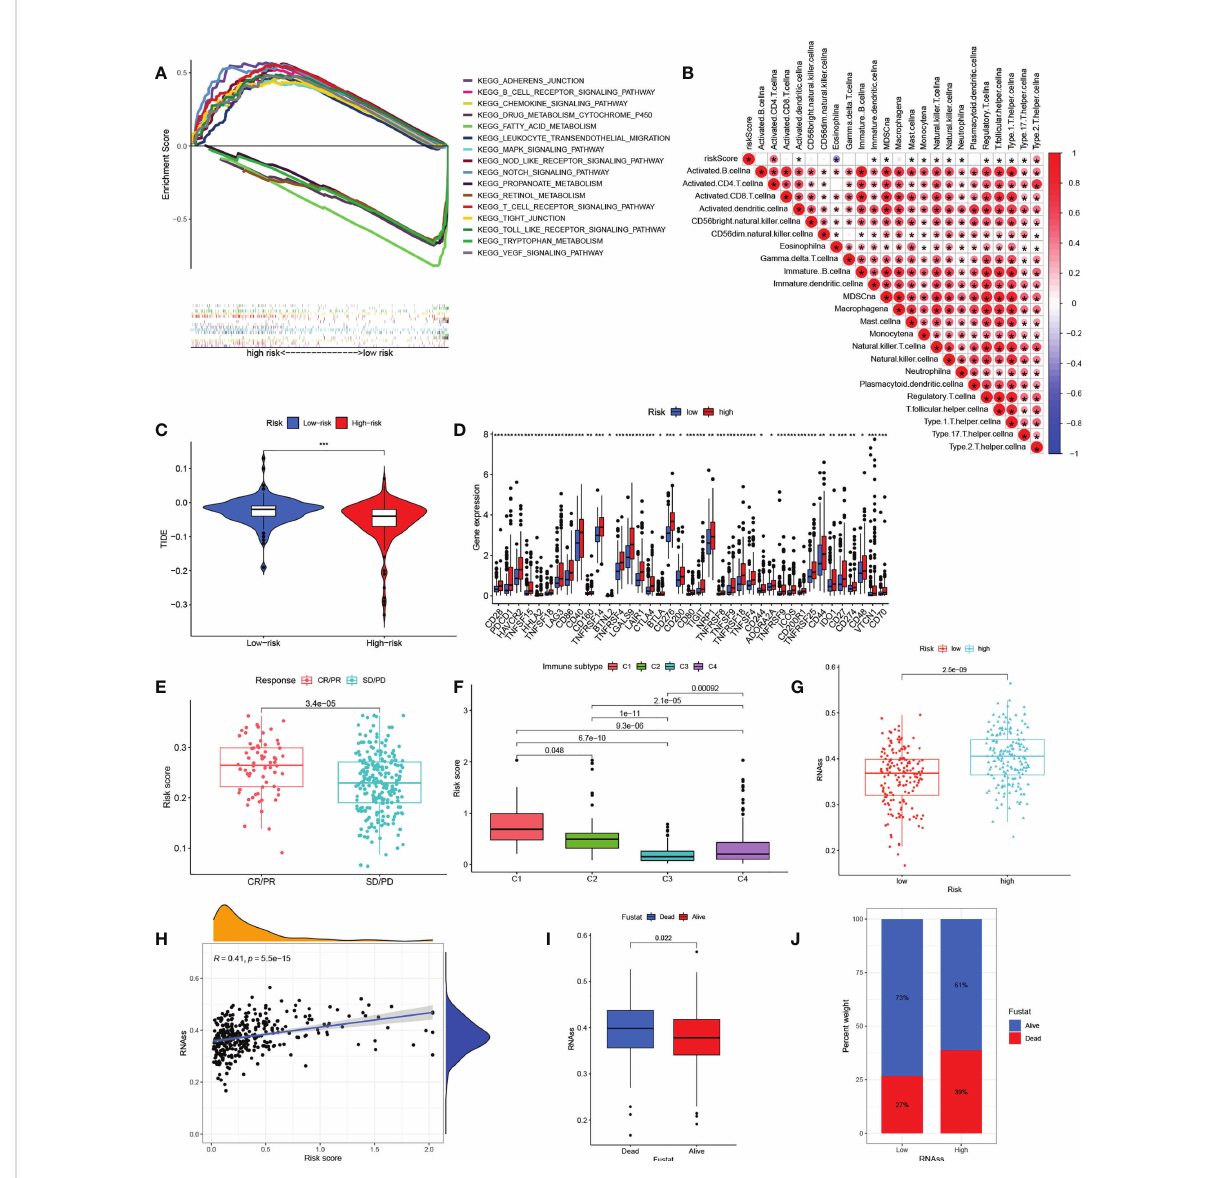
FIGURE 6 The correlation between the immunity and risk signature. (A) Multiplex GSEA analysis between groups with high and low risk (B) Correlations between in fi ltration of immune cell levels and risk scores. The color blue implies a negative association; the color red denotes a positive association. (C) TIDE scores in the groups with high and low risk. (D) Expression of immune checkpoints in the groups with high and low risk. (E) Risk scores in anti-PD1/PD-L1-treated CR/PR samples and SD/PD samples in the IMvigor210 cohort. (F) Risk scores in relation to immune cell subtypes. (G) RNAss values in the groups with high and low risk. (H) Relationships between risk scores and RNAss values. (I) RNAss values in deceased and surviving patients. (J) Proportions of deceased and surviving patients in the groups with high and low RNAss. GSEA, gene set enrichment analysis; TIDE, tumor immune dysfunction and rejection; PR, partial response; CR, complete response; PD, progressive disease; SD, stable disease; RNAss, RNA stemness scores. The asterisks represented the statistical p value (*P < 0.05; **P < 0.01; ***P <